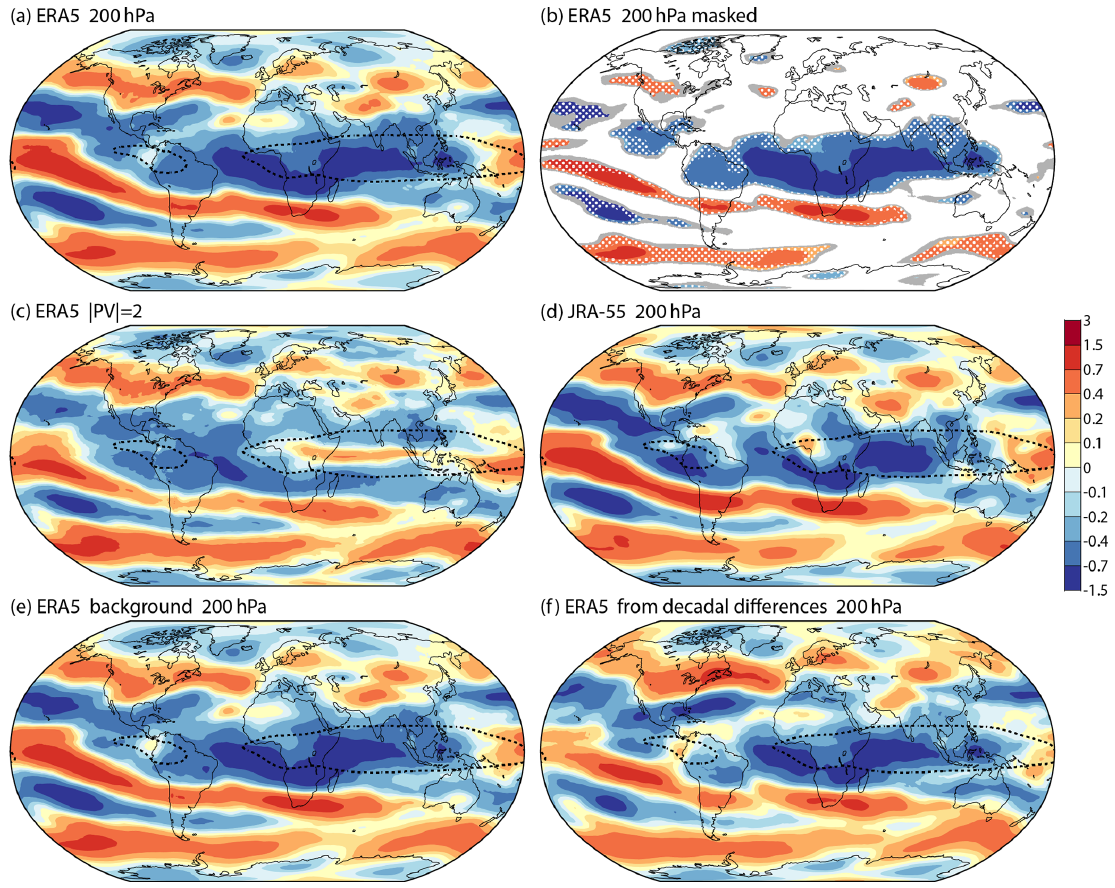
Figure 7. The least squares linear trend (ms − 1 per decade) in monthly average zonal winds from March 1979 to February 2022 for (a, b) ERA5 at 200hPa, (c) ERA5 at | PV |= 2, (d) JRA-55 at 200hPa and (e) the ERA5 background at 200hPa. White and grey shad- ings completely mask the trend in panel (b) except where the 95% confidence interval is one-signed. The grey shading shows where masking would be reduced by using a 90% confidence interval; white dots show the additional masking provided by a false-discovery-rate adjustment. Panel (f) shows the corresponding 200hPa trend for ERA5 derived from the average change from the first to the last 120 months of the period. The dotted black contours show the boundaries of the two regions of climatological easterly tropical flow depicted in Fig.